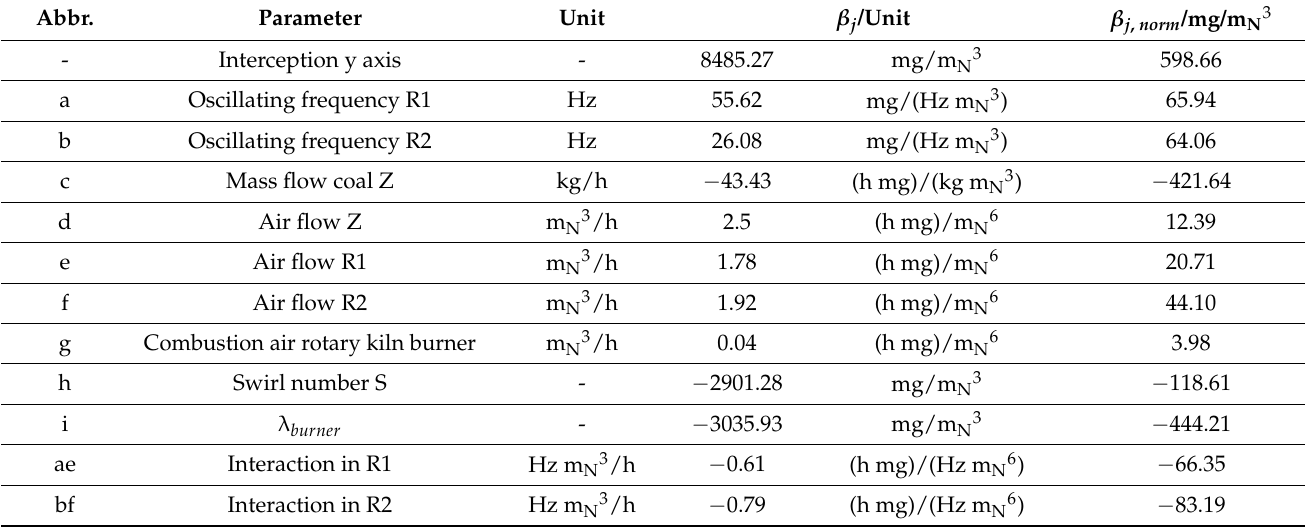
Table 5. Regression coefficients of the expert